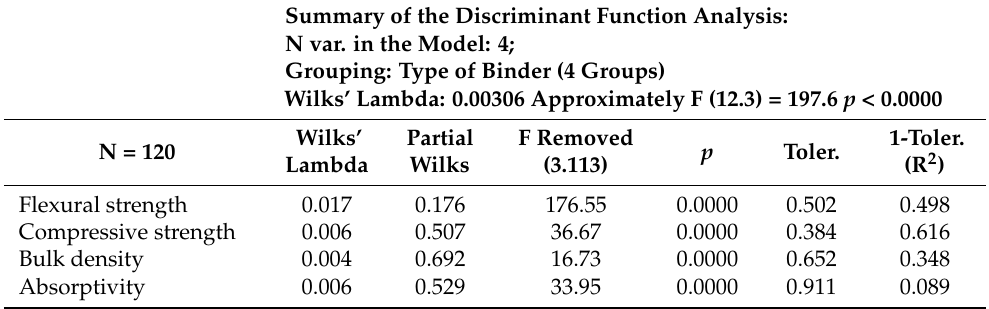
Table 4. Assessment of the contribution of individual variables to the overall discrimination of mortars. Summary of the Discriminant Function